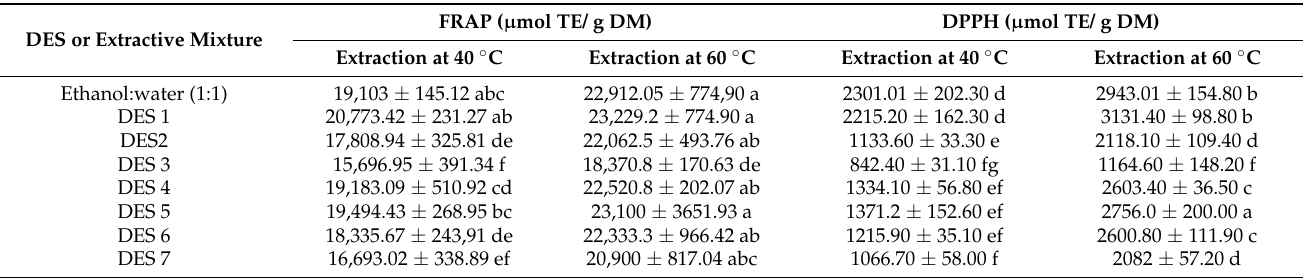
Table 5. Results of antioxidant capacity for group 1 extractions from